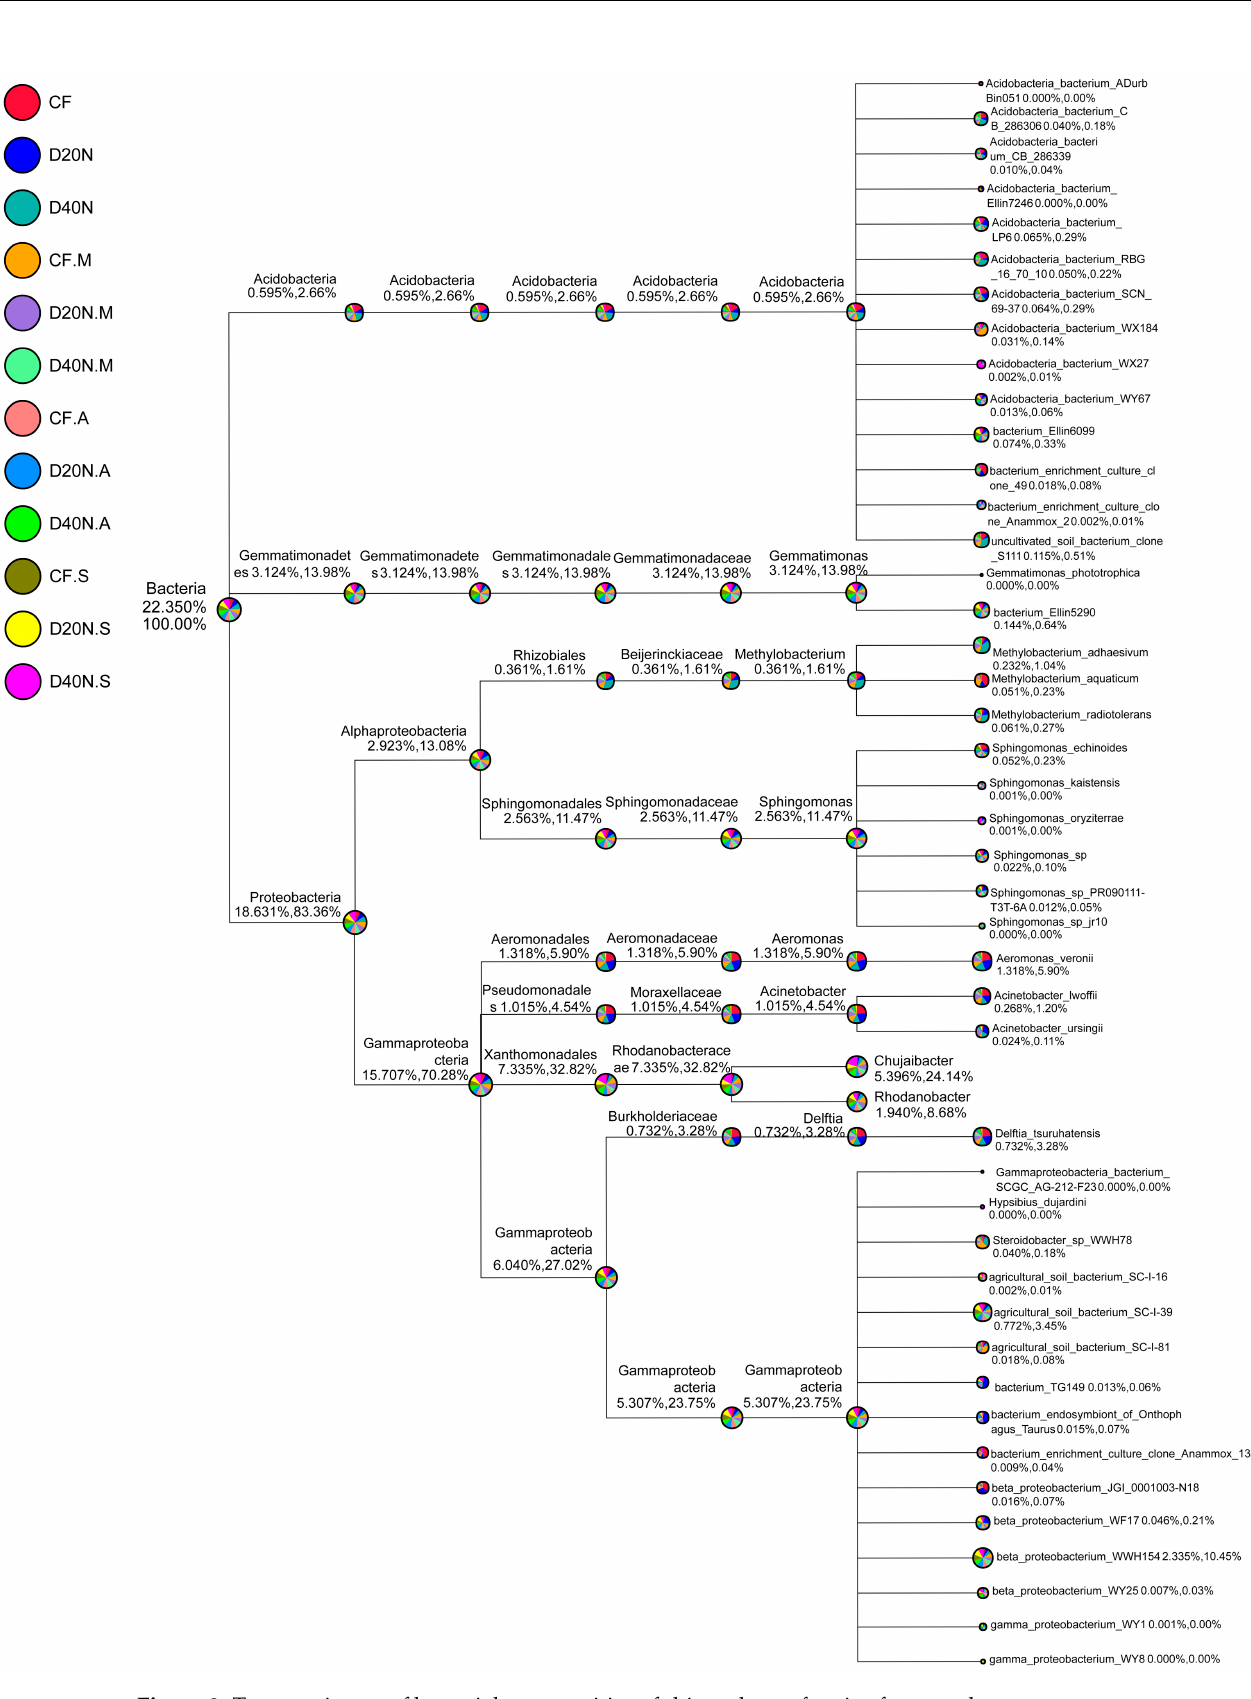
Figure 2. Taxonomic tree of bacterial communities of rhizosphere of maize from twelve treatments.